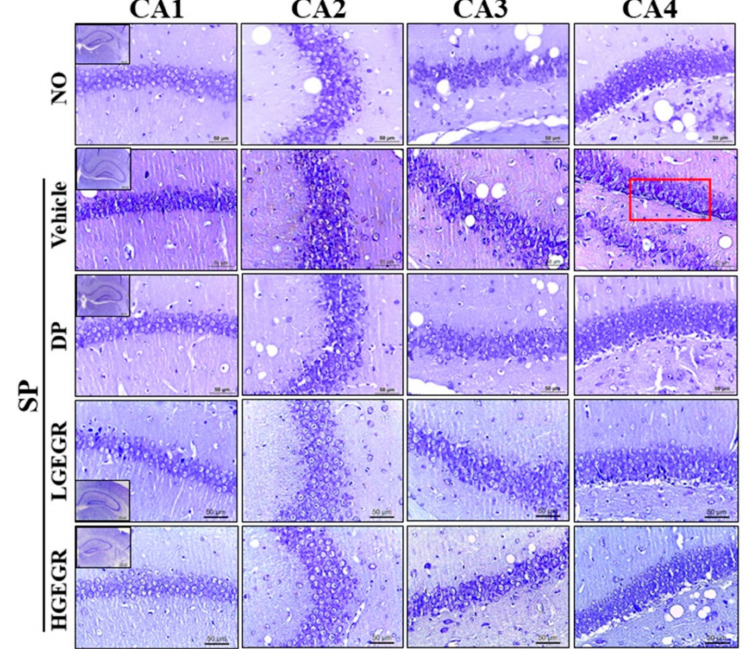
Figure 7. Observation of Nissl-stained neurons in the hippocampus of mice. After SP injection into mice pretreated with GEGR for three weeks, brain tissues were collected from each group and histological changes were assessed as described in Materials and Methods. Slides bearing sections of brain tissue were stained with Nissl and then observed at 400 × magnification. Abbreviation: DP, donepezil; GEGR, gallotannin-enriched extract of Galla Rhois; SP, scopolamine; CA, cornu ammonis.